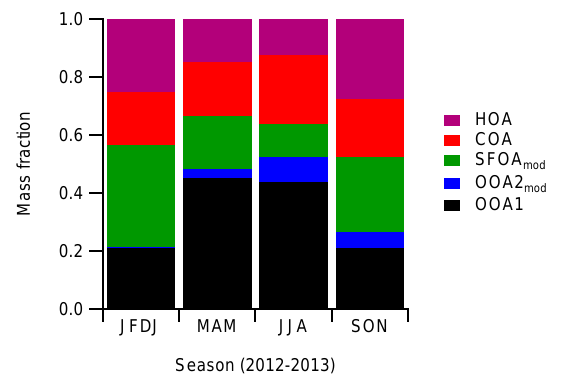
Figure 5. Seasonal fractional contributions of the PMF factors to total OA mass, with revised masses (see Sect. 4.4). As discussed in Sect. 4.1, a period from the summer is not included in these data.